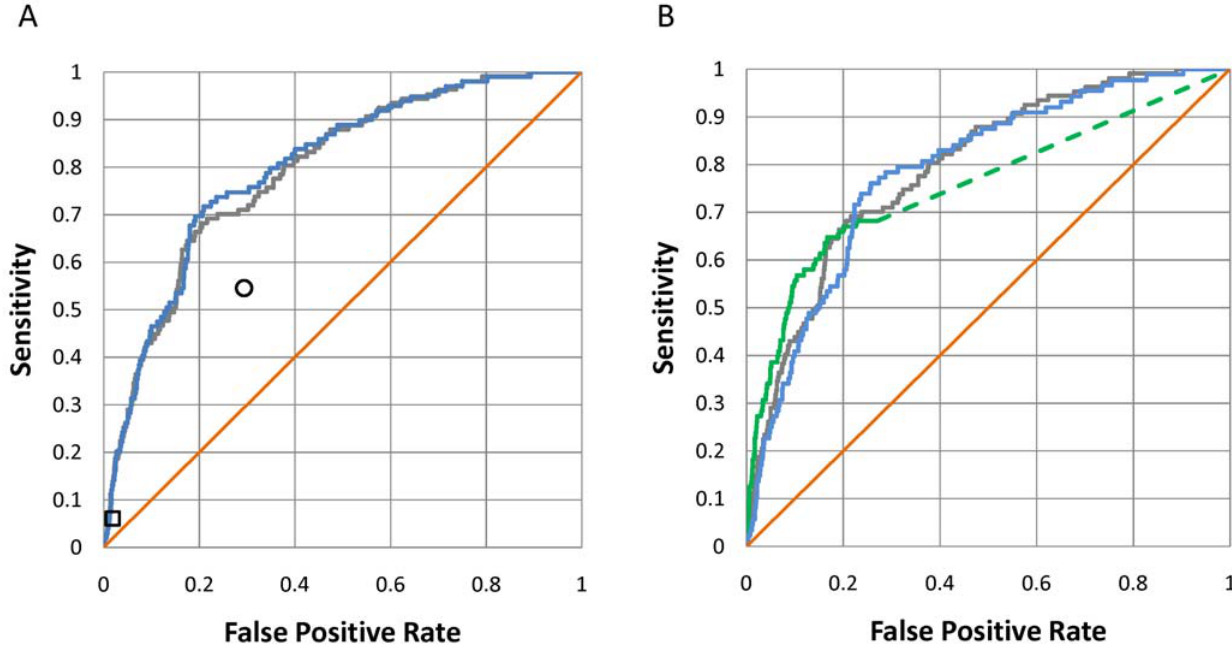
Figure 3. Prediction of SH2-mediated protein-protein interactions using FoldX and experimental data from peptide libraries. The orange line corresponds to random prediction, and the grey line to prediction for all nine domains in Table 1. (A) Comparison of predictions from experimental consensus sequences allowing zero (square) and one mismatch (circle) with the consensus sequence with FoldX predictions for the eight domains in Table 1 for which a consensus sequence is available (blue line). (B) Comparison of predictions from Scansite scoring matrices for the Nck1, p85, Src, Lck, and Grb2 SH2 domains (green line) with FoldX predictions for the same domains (blue line).